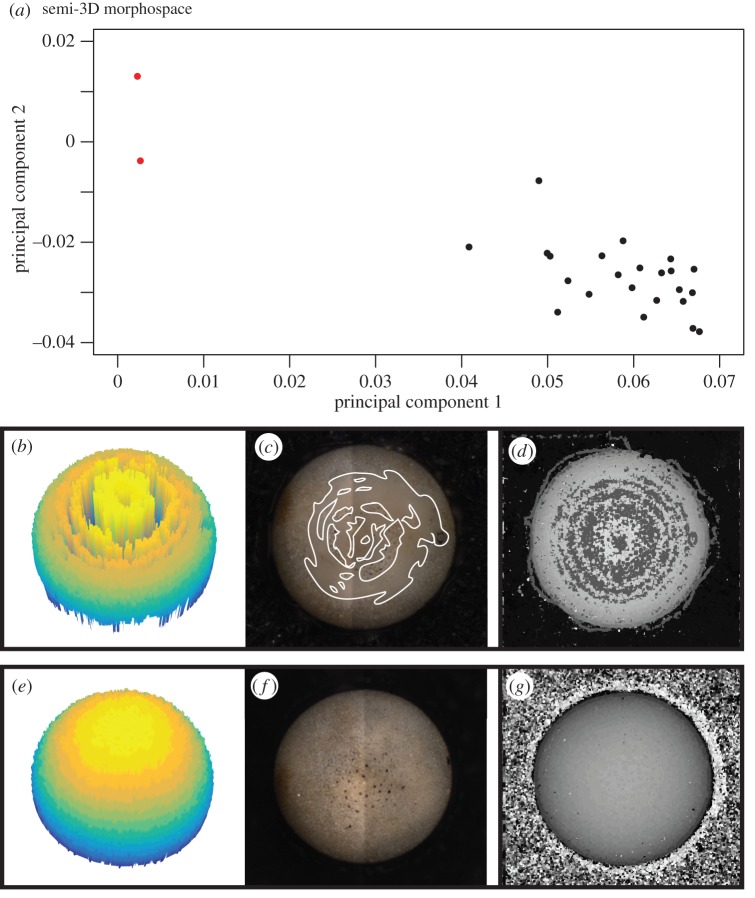
Exploration of the reproducibility tests of the Orbulina universa individual (a) The PC1 versus PC2 coordinates for O. universa from figure 8c. The points highlighted in red are outliers for which the run3dmorph-extracted semi-3D half-hulls exhibited pathologies (see text). (b–d) Extracted mesh, focused image and height map showcasing pathologies arising during z-stack focusing. In (c), the smeared, unfocused portions of the object are outlined in white. (e–g) The corresponding mesh, focused image and height map for a properly extracted O. orbulina individual.